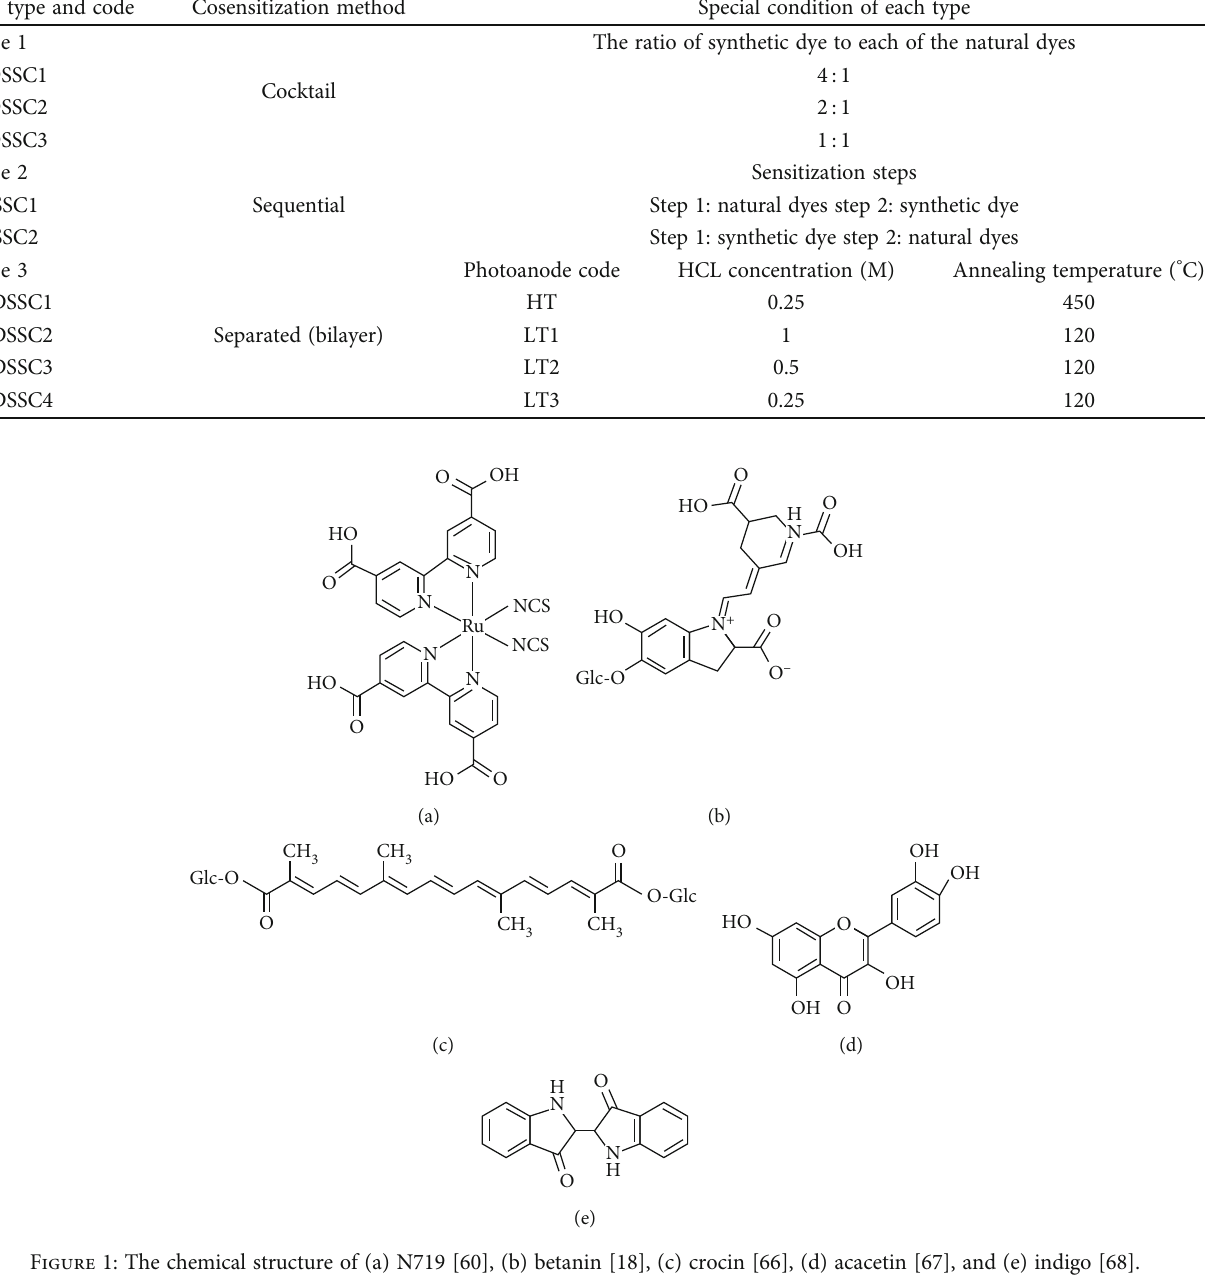
Table 1: The sensitization methods and the synthesis conditions of fabricated solar cells.